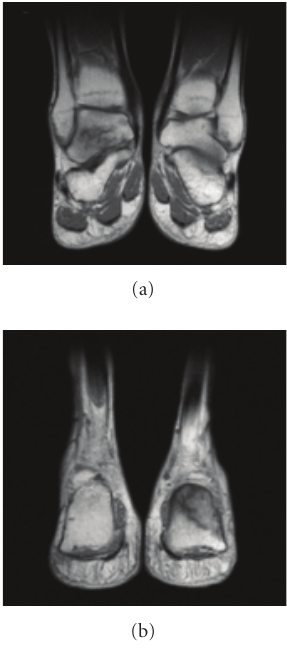
Figure 1: Case 1: T1-weighted magnetic resonance (MR) demon- strating stress fractures of (a) right talus and (b) left